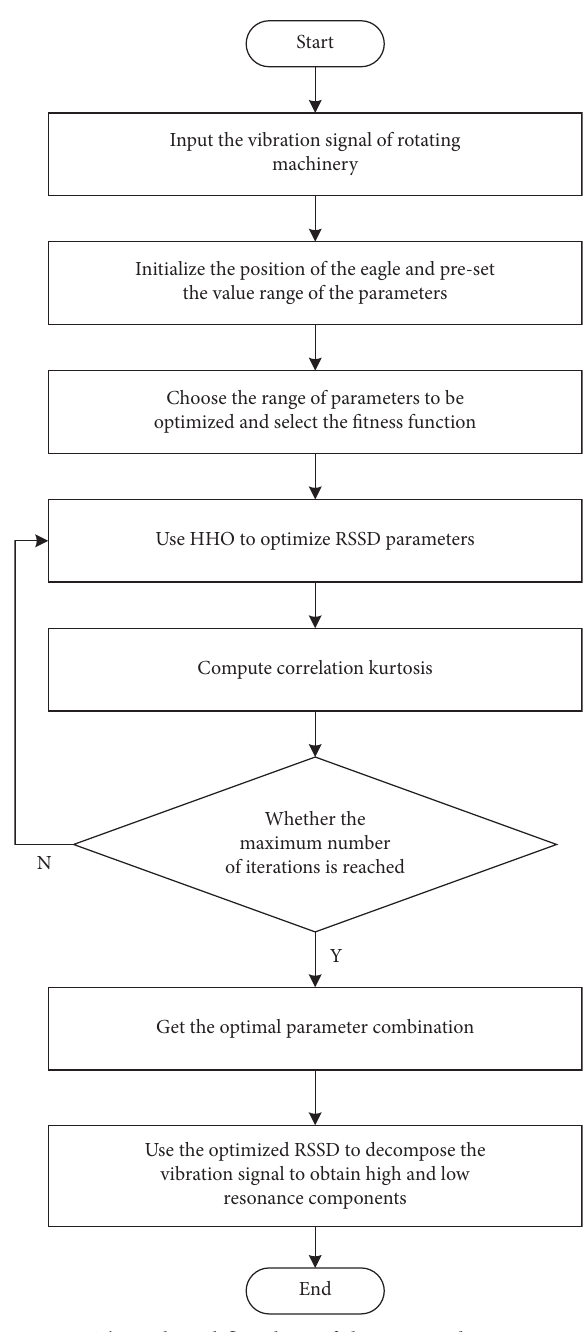
Figure 2: The technical flowchart of the proposed HHO optimi- zation